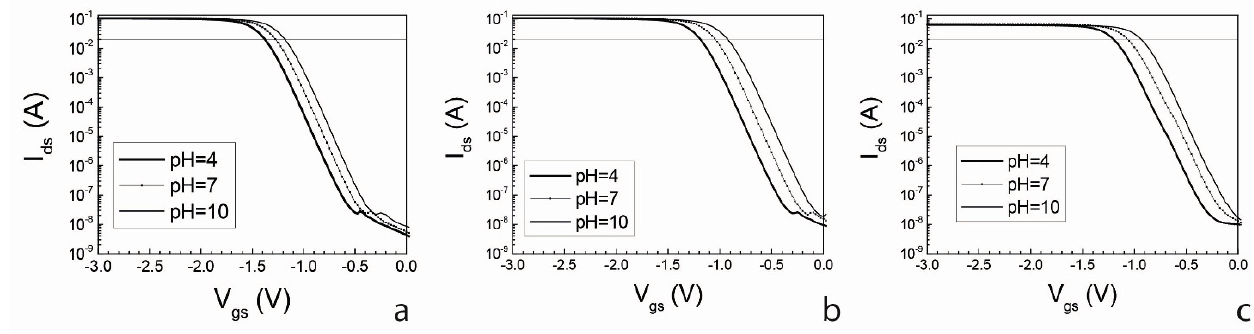
Figure 9. Extended gate transfer I ds -V gs characteristics of ITO PCB (Indium Tin Oxide Printed Circuit Board) sensors for ( a ) commercial Ag/AgCl; ( b ) chlorinated Ag wire; and ( c ) Ag/AgCl PCB reference electrodes.